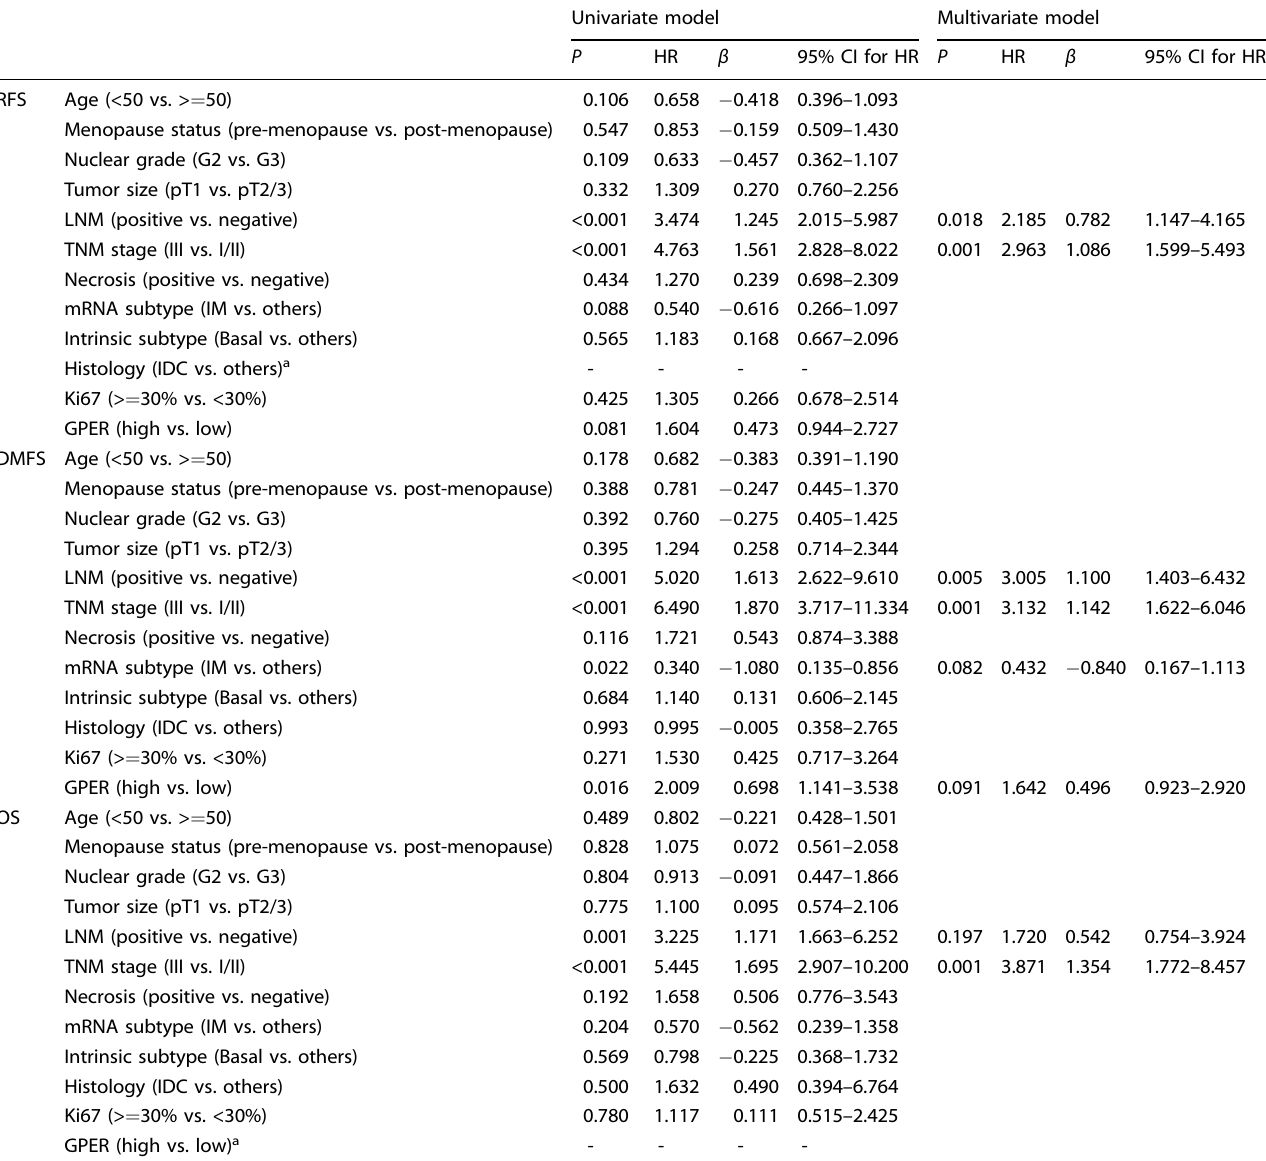
Table 2. Univariate and multivariate survival analyses of clinicopathological factors and GPER